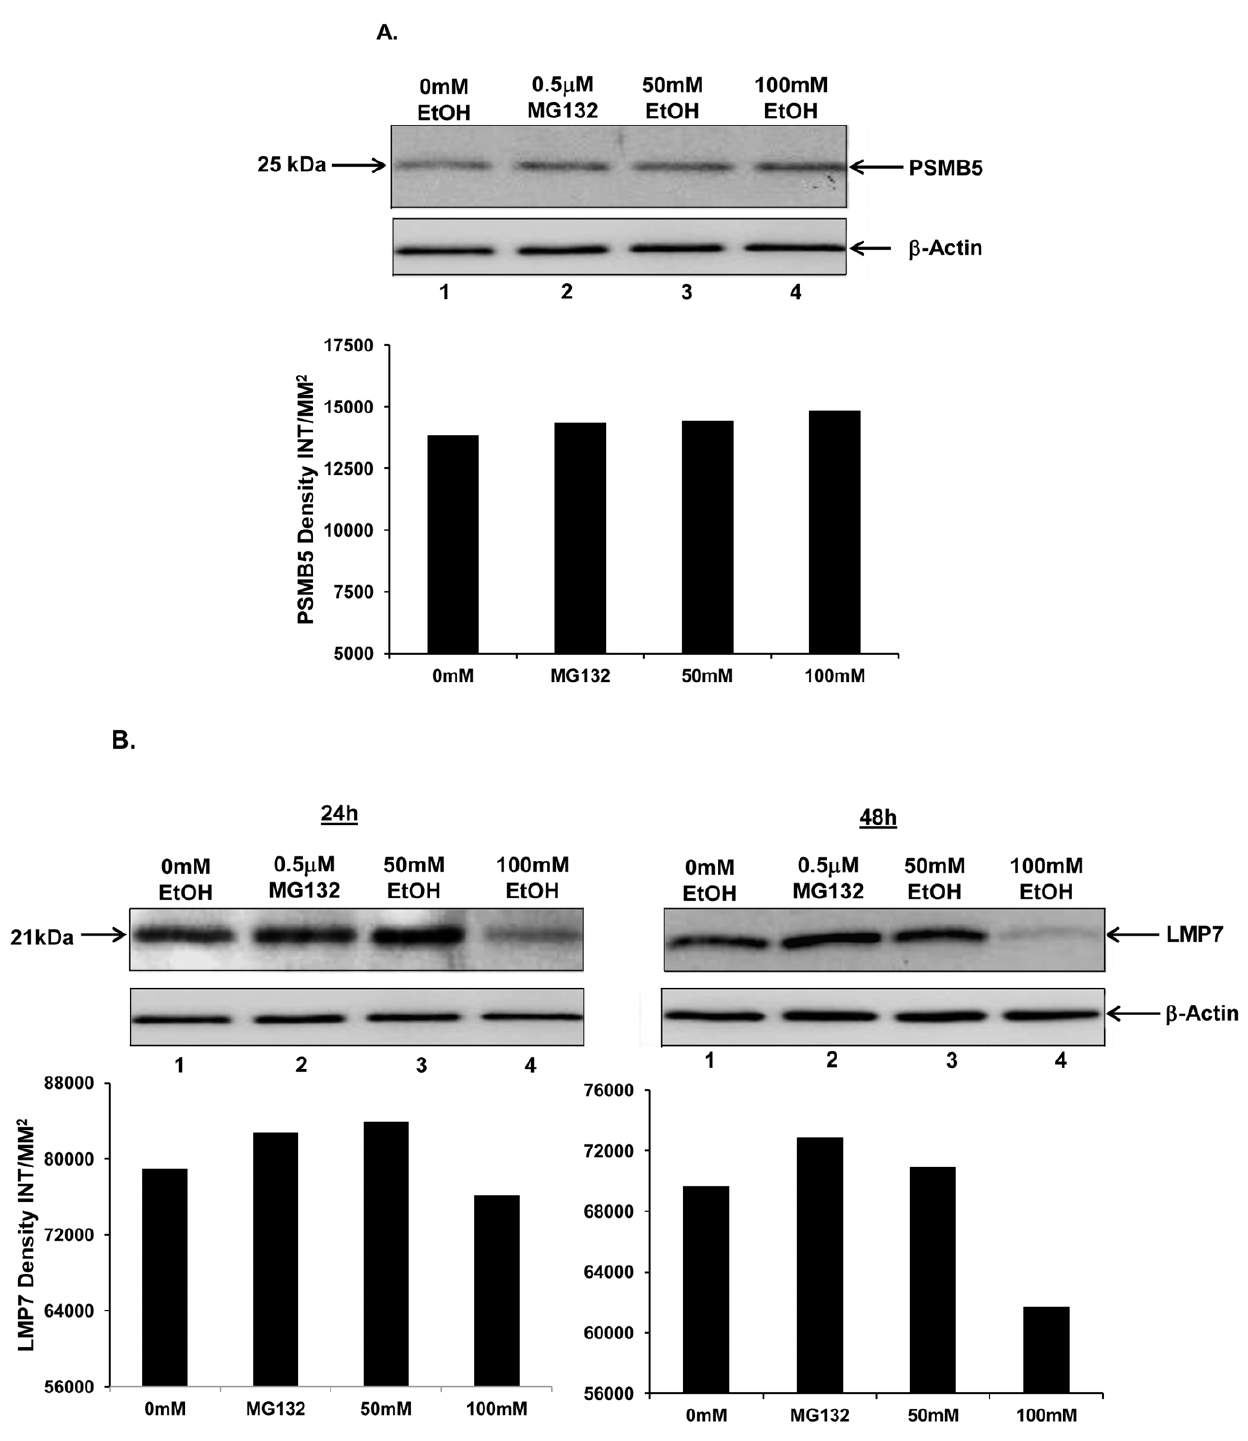
Figure 2. Ethanol does not alter steady-state protein levels of constitutive proteasome subunit beta 5 (PSMB5), but suppresses steady-state protein levels of immunoproteasome subunit LMP7. A. Murine unstimulated RAW 264.7 cells (2 6 10 5 cells/ml) were treated with 50 mM (lane 3) or 100 mM (Lane 4) ethanol (EtOH) for 48 h. Cells were also treated with MG132 (0.5 uM) (lane 2) as a positive control of proteasome inhibition. 0 mM (control) cells received no treatment (lane1). Cell lysates were obtained 48 h post EtOH exposure. The lysates of triplicate samples were pooled for gel loading, analyzed by 15% SDS-PAGE and immunoblotted with anti-PSMB5 antibody as described in the methods (upper panel). The membrane was stripped and reprobed with anti-beta-actin antibody to ensure equal protein loading as described in the methods section (lower panel). The bar graph represents densitometry quantitation of PSMB5 levels between treatment groups and is represented as INT/mm 2 . The depicted gel blot is representative of two independent experiments. Each band of the blot represents the pooled lysates from three independently treated samples. B. Unstimulated RAW 264.7 cells (2 6 10 5 cells/ml) were treated with 50 mM (lane 3) or 100 mM (lane 4) EtOH for 24 h (Left panel) or 48 h (Right Panel). Cells were also treated with MG132 (0.5 uM) (lanes 2) as a positive control of proteasome inhibition. 0 mM (control)